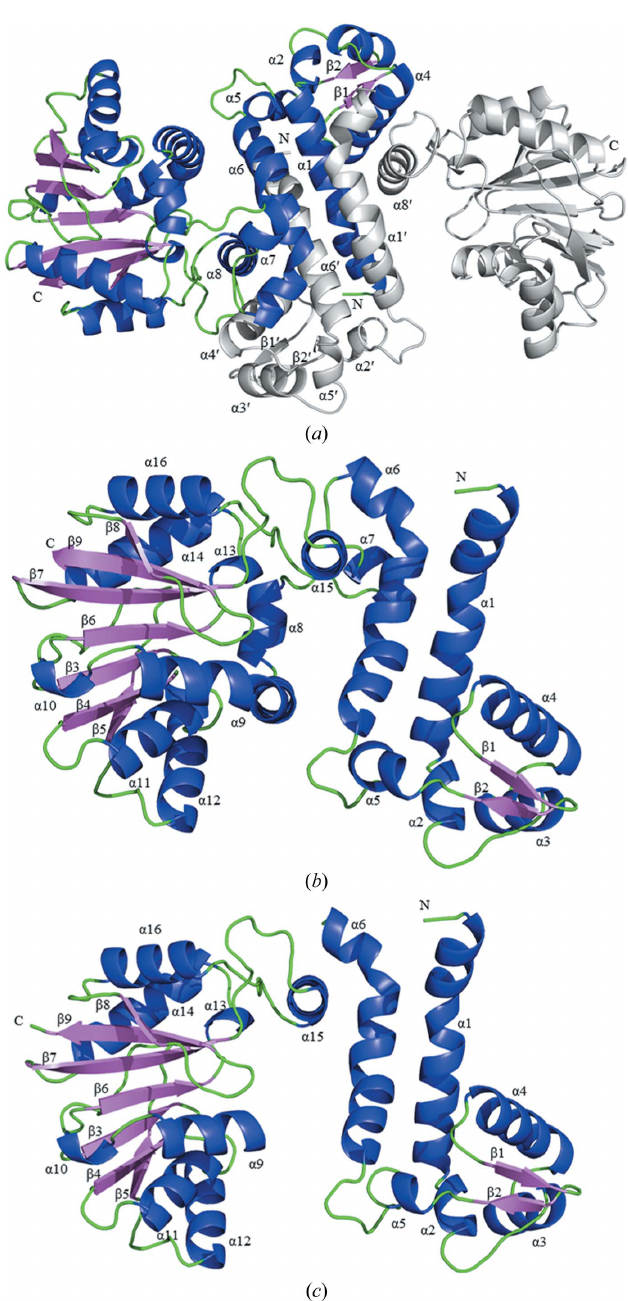
Figure 4 Overall structure of apo PigF. ( a ) The structure of the PigF homodimer. The helices, sheets and loops of monomer A are shown in blue, violet and green, respectively; monomer B is coloured grey. Secondary-structure elements involved in the dimer interface are labelled. ( b ) Chain A of PigF; helices, sheets and loops are shown in blue, violet and green, respectively. ( c ) Chain B of PigF, which lacks residues 117–152; helices are coloured blue, strands are coloured violet and loops are shown in